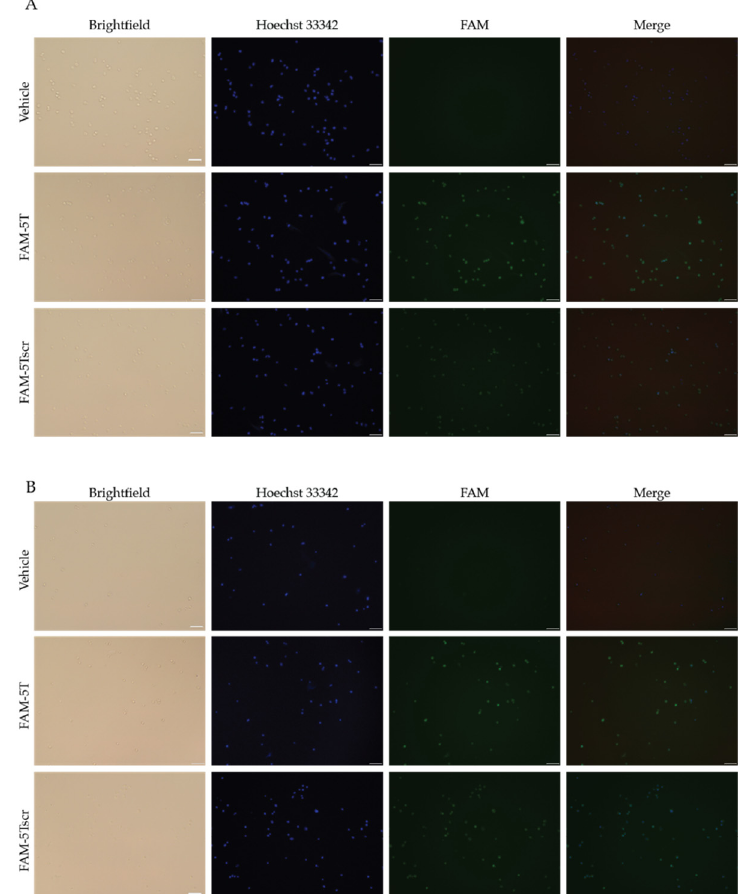
Figure 6. DNAi 5T nuclear localization is enhanced with MYC G4 stabilization by NSC 338258 in RAJI Burkitt’s lymphoma cells. RAJI cells were incubated with the indicated DNAs alone ( A ) or in the presence of 2.5 μ M NSC 338258 ( B ) for 24 h before fluorescence visualization. No FAM accumulation is noted in the transfection vehicle controls without DNAi. 5T is noted to accumulate in the cells and in the nuclei ~80% more than 5T scr in the absence of NSC 338258. Co-incubation with the MYC G4-stabilizing compound increases the mean FAM penetration ~2-fold for 5T, with no measurable change in 5Tscr accumulation. Images are representative of duplicate experiments with triplicate images collected within each experiment.